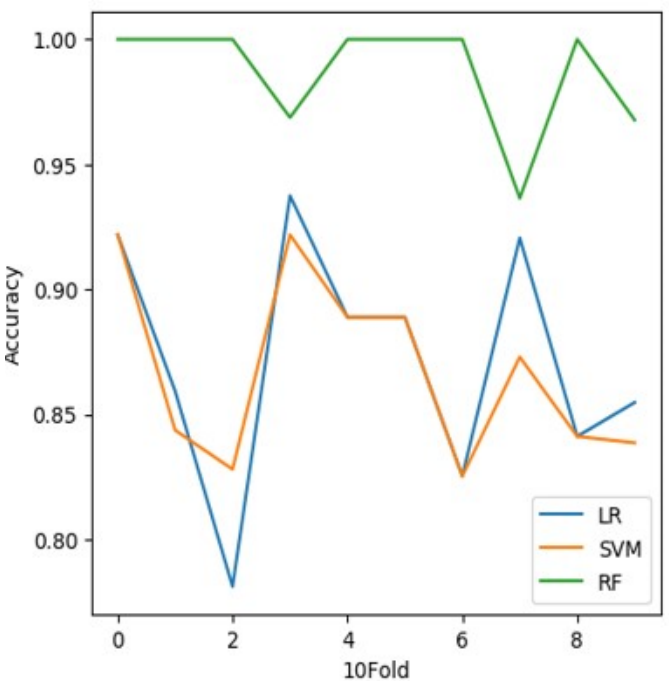
Figure 2. Comparison analysis of different classifiers over 10 folds.